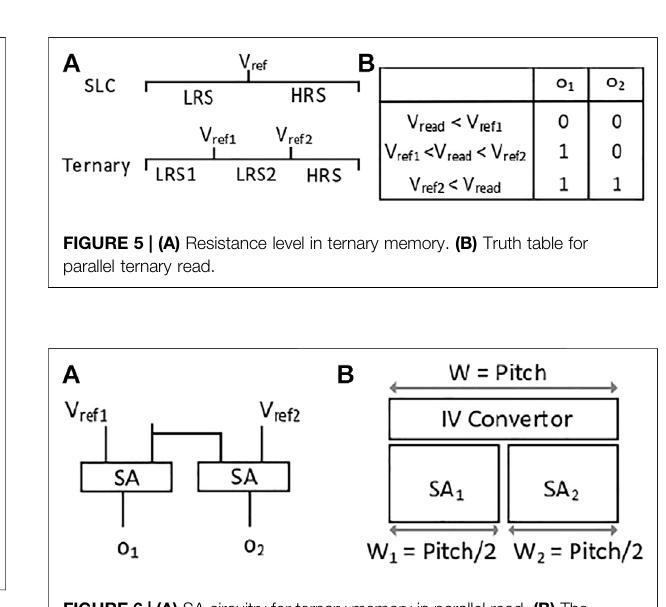
FIGURE 6 | (A) SA circuitry for ternary memory in parallel read. (B) The ternarySAblock layout.Pitch isthemaximum allowed widthfor oneSAlayout in